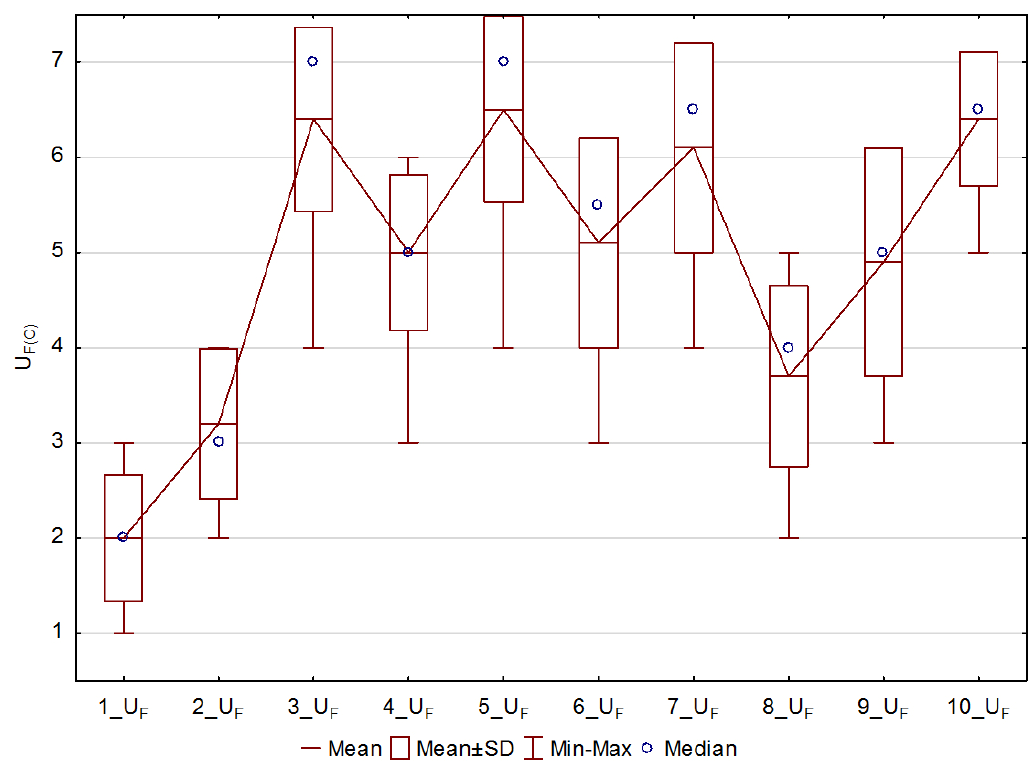
Figure 18. Floor uniformity perception for group C.